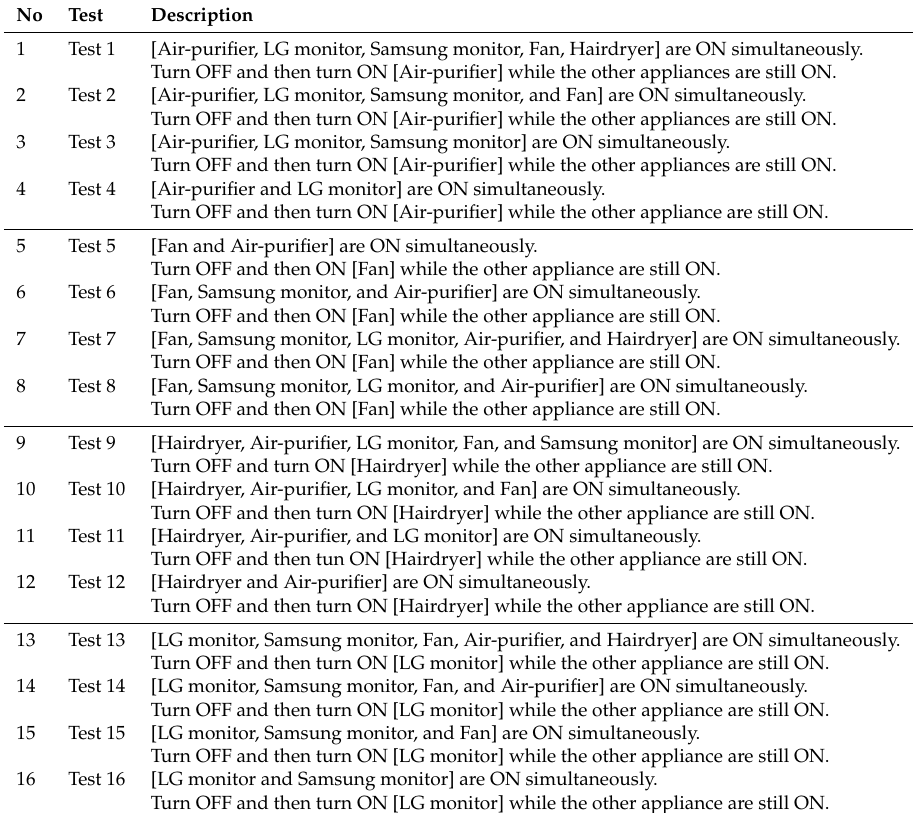
Table 2. Twenty tests data